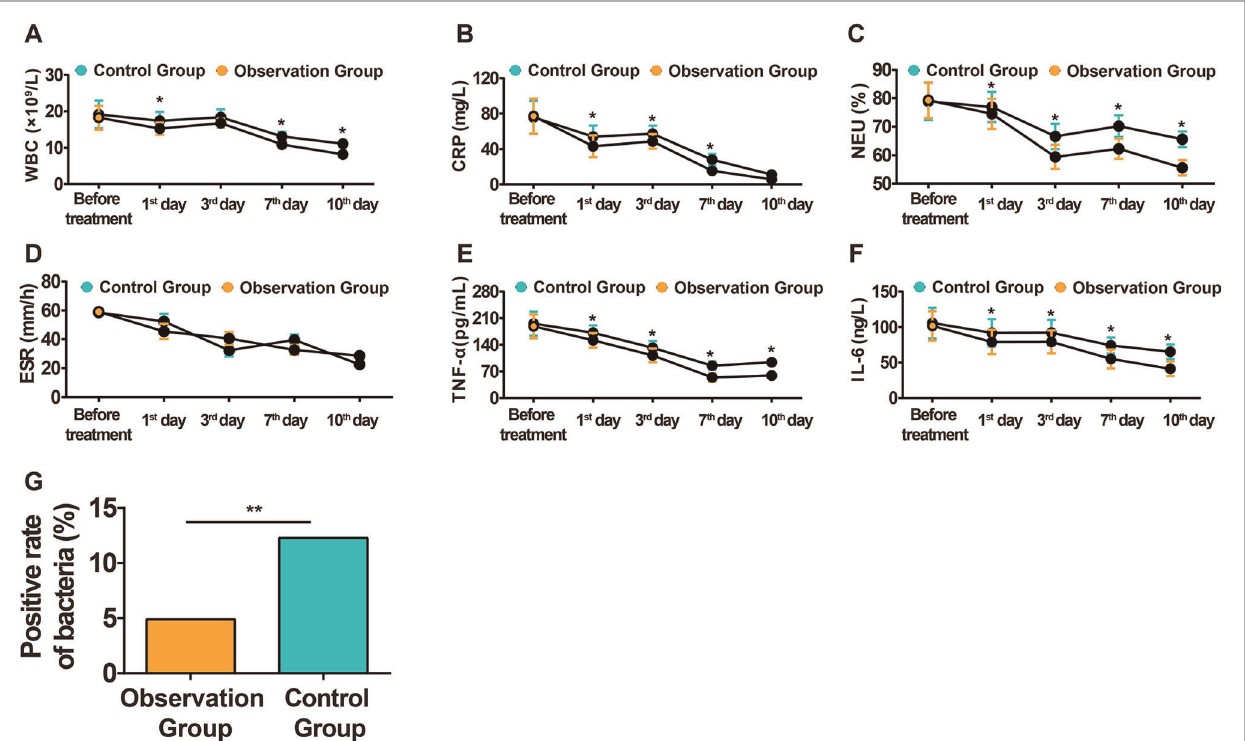
FIGURE 2 | Comparison of in fl ammatory reaction in both groups. ( A ) Changes in the WBC level in blood. ( B ) Changes in the CRP level in serum. ( C ) Changes in the NEU% level in blood. ( D ) Changes in the ESR level in blood. ( E ) Changes in the TNF- α level in serum. ( F ) Changes in the IL-6 level in serum. ( G ) Bacterial positive detection rate on the 7th day after the operation. * P <0.05, ** P <0.01.